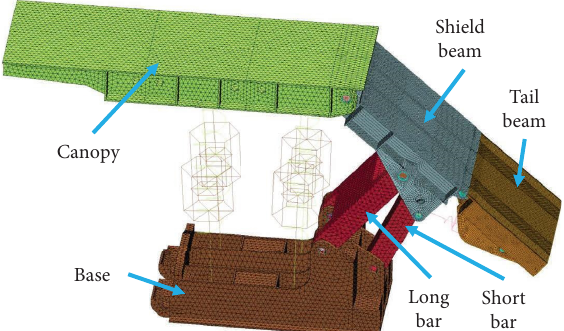
Figure 5: Te fnite element model of hydraulic